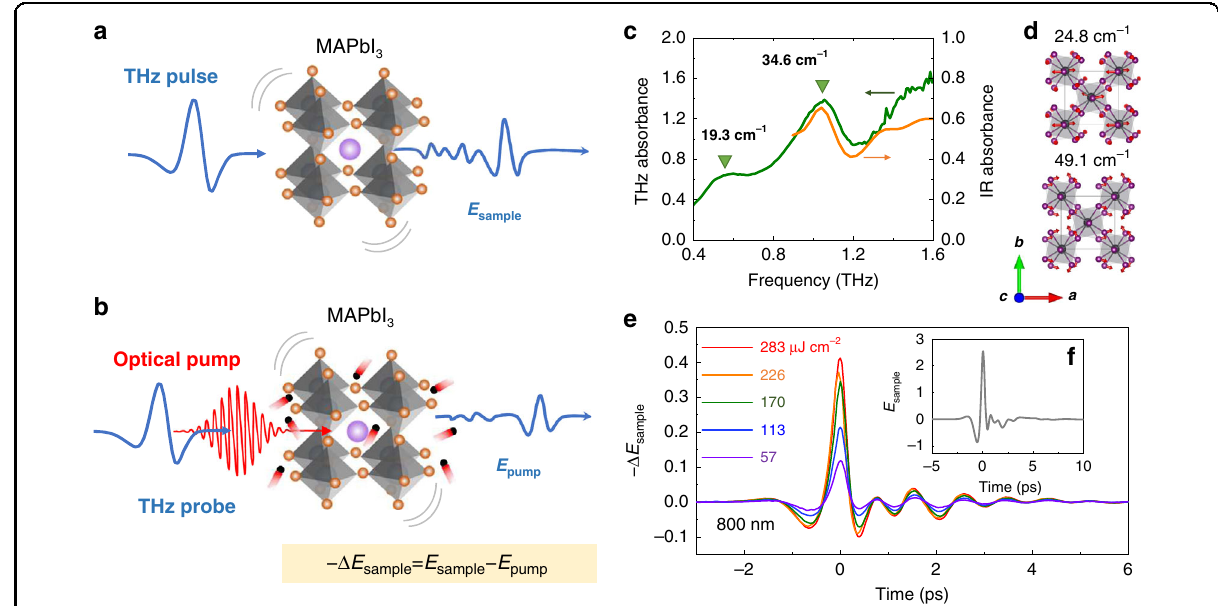
Fig. 1 OPTP measurement scheme and sample characterizations. a , b Schematic illustration of the OPTP spectroscopy on MAPbI 3 . The quickly- oscillating pulse (red) is the optical pump beam, and the time-delayed single-cycle pulse (blue) represents the THz probe beam. c THz and FTIR absorbance spectra from 0.4 to 1.6 THz. d DFT calculated I-Pb-I bending motions at 24.8 and 49.1 cm − 1 of MAPbI 3 . The gray and purple balls denote Pb and I atoms, respectively. e Time-domain signals transmitted through the MAPbI 3 polycrystalline grains covered on a double-sided tape for different pump fl uences (800 nm excitation). f A transmitted THz waveform through the sample without